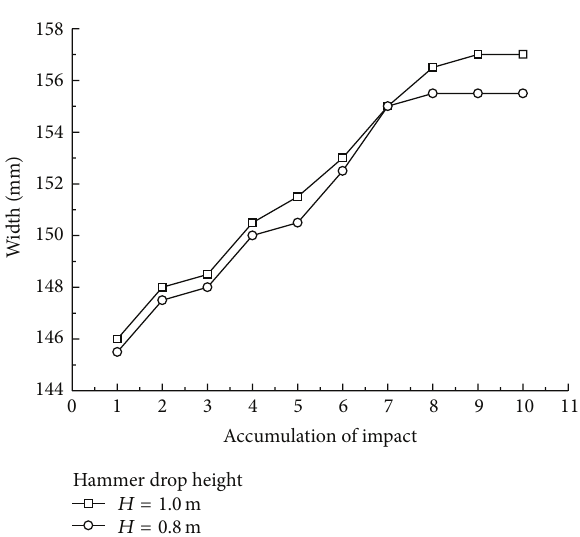
Figure 4: Relationship of soil settlement with the number of impact loading.